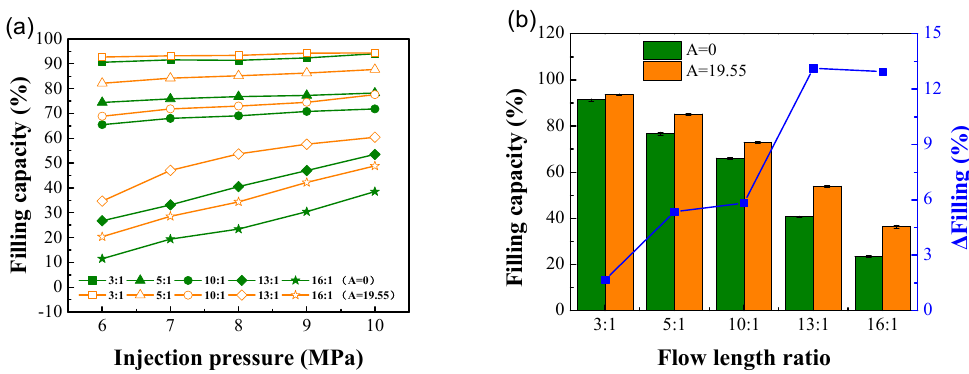
Figure 6. E ff ect of injection pressure on the filling capacity. ( a ) Filling capacity at di ff erent injection Figure 6. Effect of injection pressure on the filling capacity. ( a ) Filling capacity at different injection pressures; ( b ) Filling capacity at di ff erent flow length ratios and an injection pressure of 8 pressures; ( b ) Filling capacity at different flow length ratios and an injection pressure of 8 MPa.